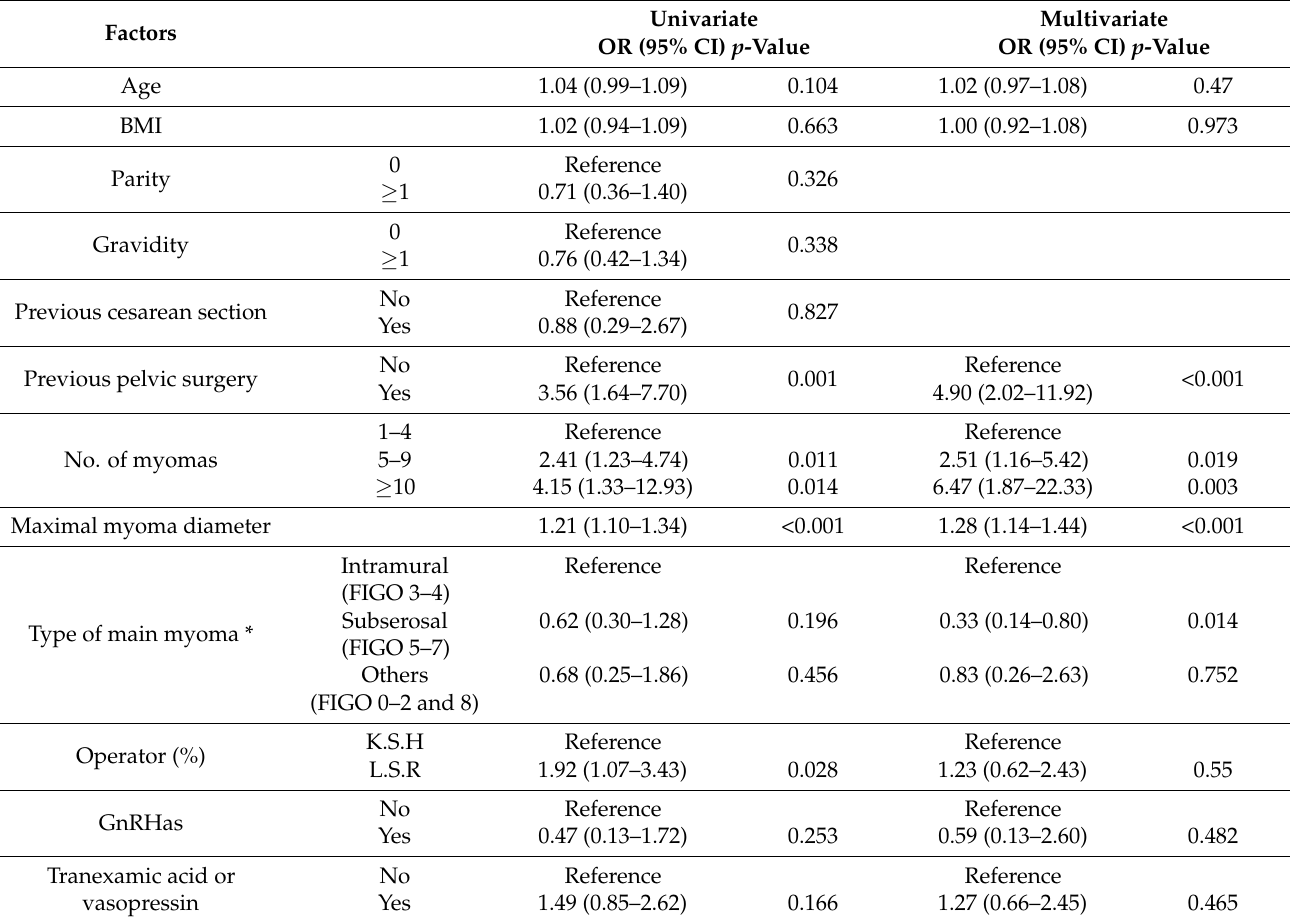
Table 2. Univariate and multivariate logistic regression analyses of EBL > 320